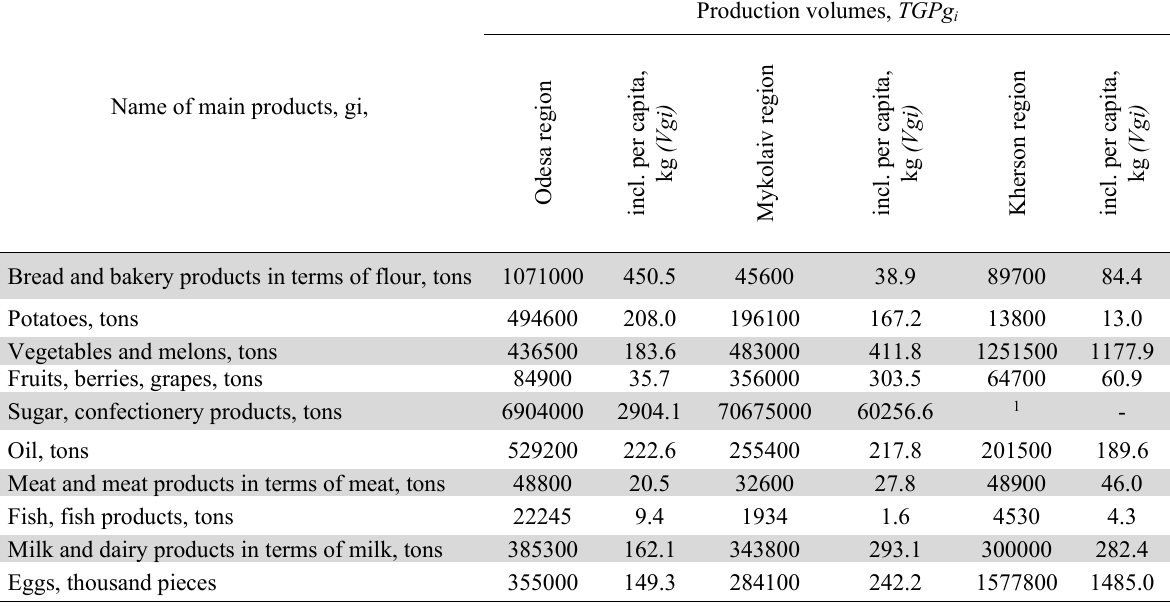
Average annual production of socially significant food products in the Black Sea region of Ukraine